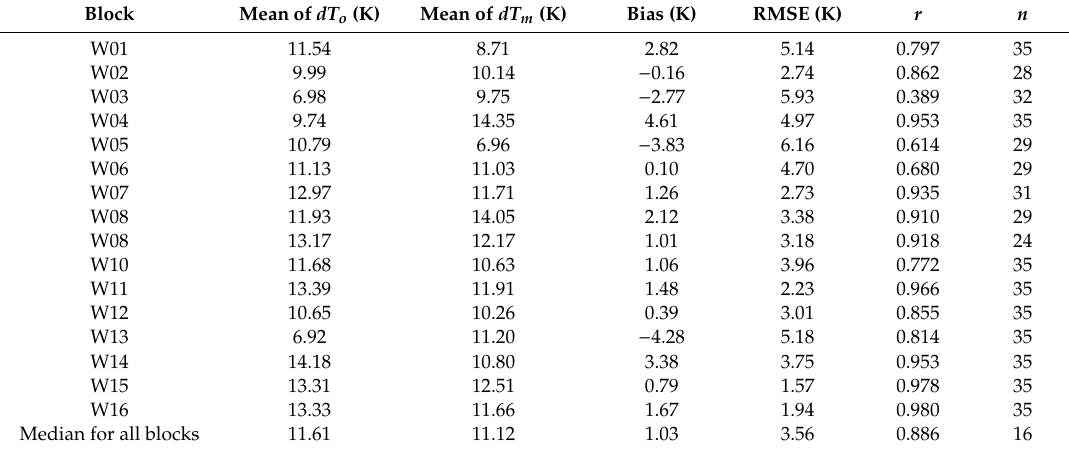
Table 2. Agreement between modeled and observed dT values for the sample blocks in the West Coast region.